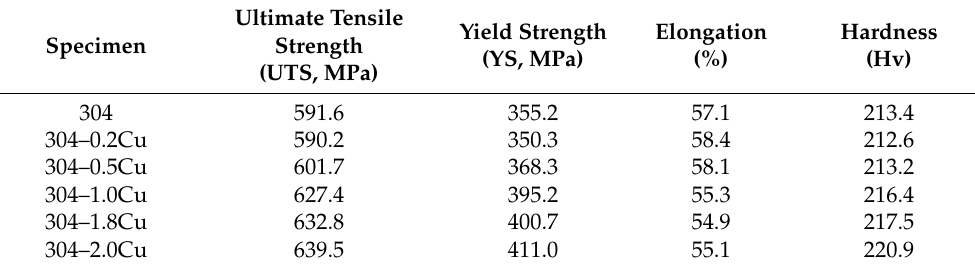
Table 2. Mechanical properties of the forged 304 stainless steel with different copper contents.